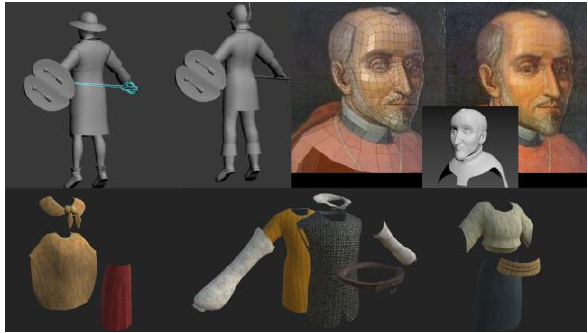
Figure. 4. Character development, including physical traits, costumes, accessories and in the case of Bishop Francisco Marroquín, his personal likeness.